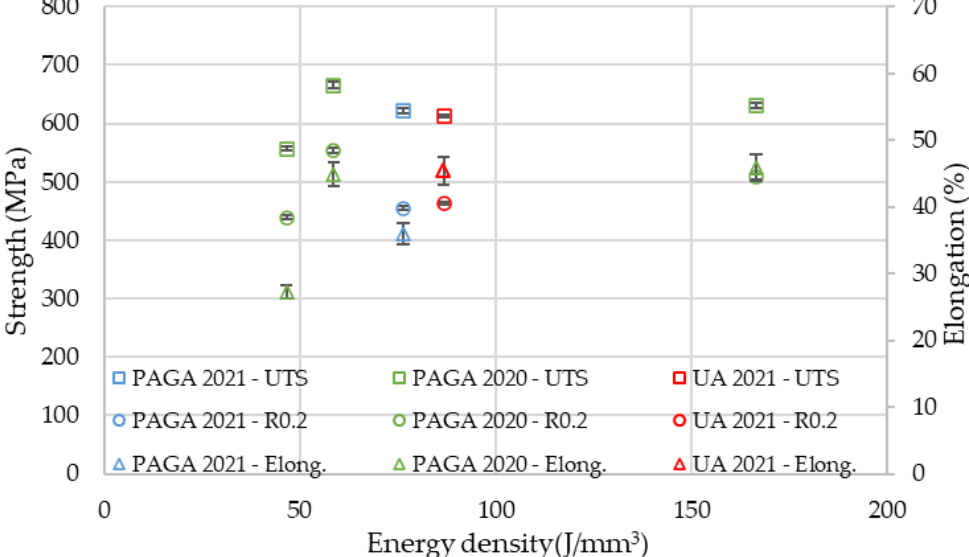
Figure 12. PAGA and UA powder sample strength and elongation vs. laser energy density (data PAGA-2020 from previous own paper [26]).